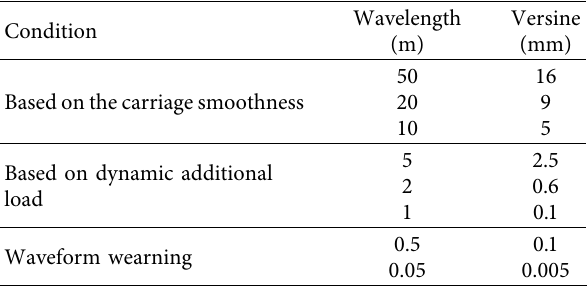
Table 2: Parameters for the train vibration load.